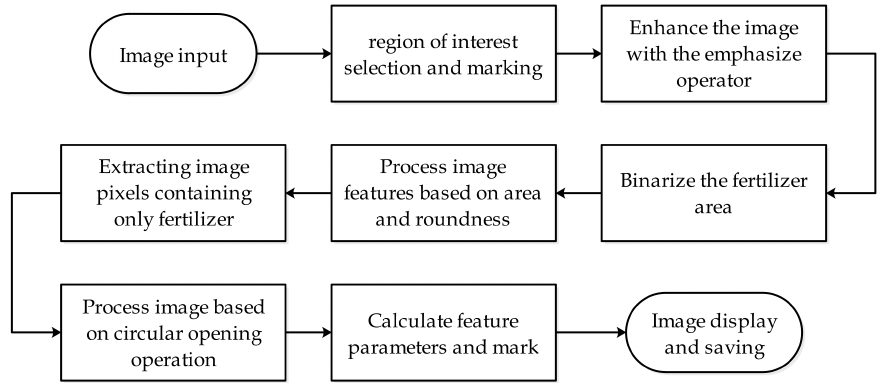
Figure 7. Flow chart showing the individual steps of the fertilizer extraction